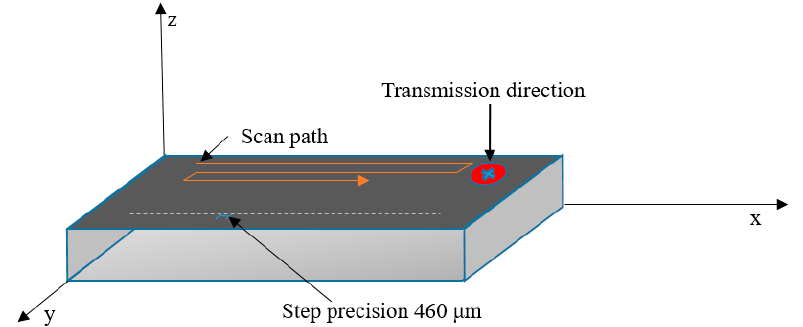
Figure 2. Schematic diagram of Ultrasonic Detection [28].